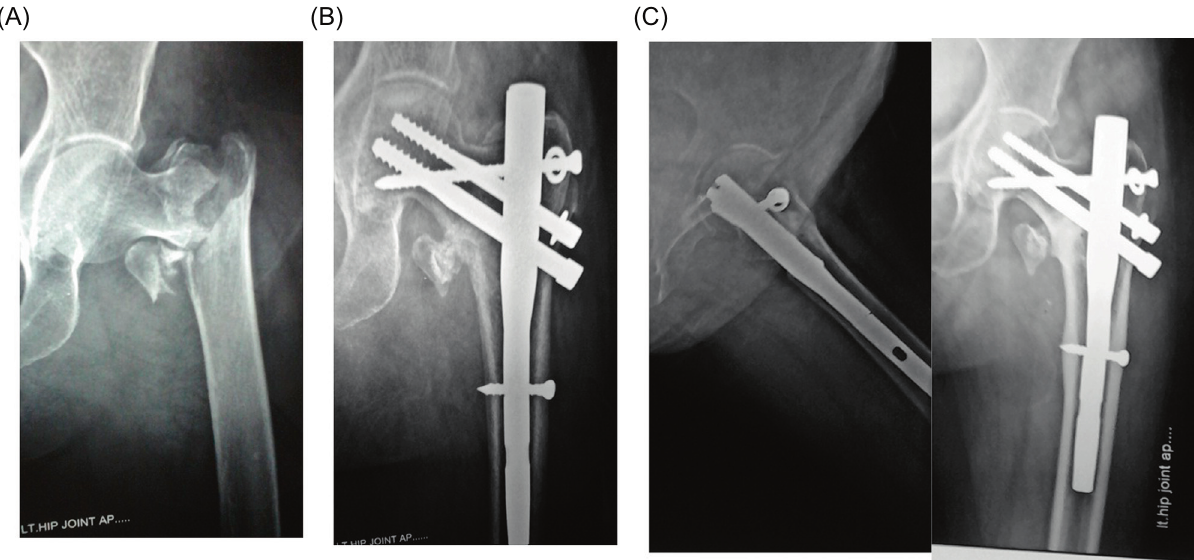
Figure 3. A 65-year-old male patient with a type 31-A3.3 fracture. (A) Initial radiograph. (B) Radiograph of the proximal femur at the 6th postoperative week with additional screw with washer. (C) Radiograph of the proximal femur at the 24th postoperative month showing complete consolidation of fracture.